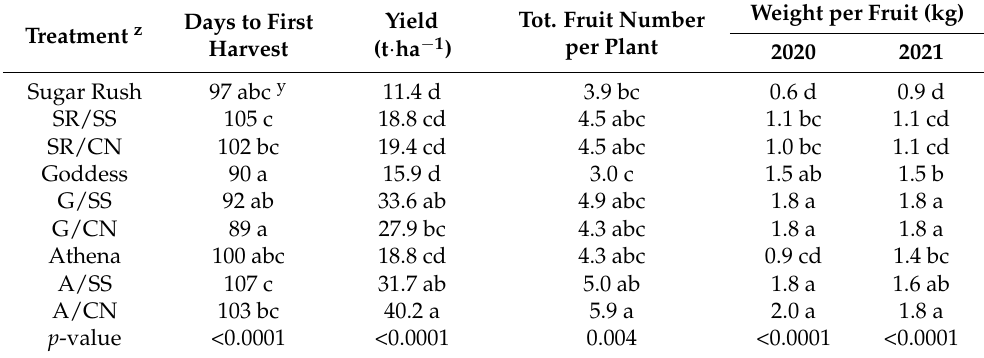
Table 4. Days to first harvest, yield (t · ha − 1 ), total fruit number per plant, and weight per fruit of cantaloupe cultivars Sugar Rush (SR), Goddess (G) and Athena (A) nongrafted and grafted onto two rootstock cultivars Super Shintosa (SS) and Carnivor (CN) at Mount Vernon, WA, USA, in 2020 and 2021 (years combined).